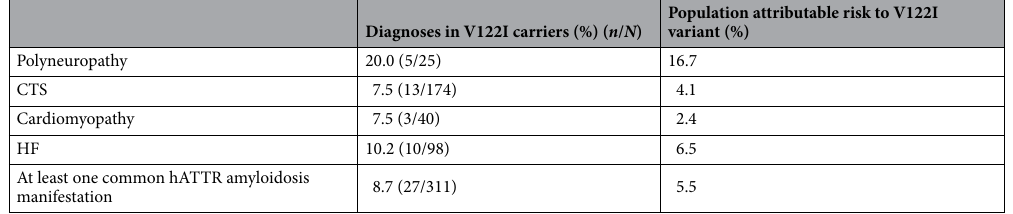
Diagnoses in V122I carriers (%) ( n / N